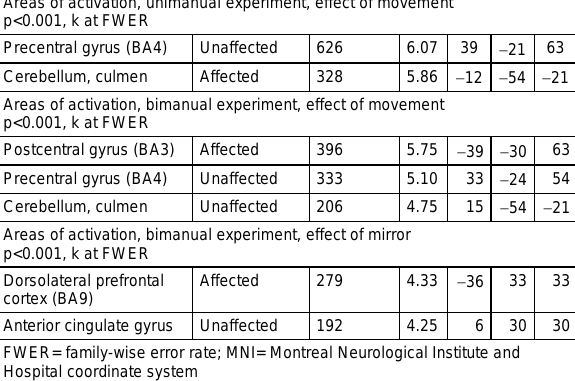
Table 1: Detailed information on all participants.